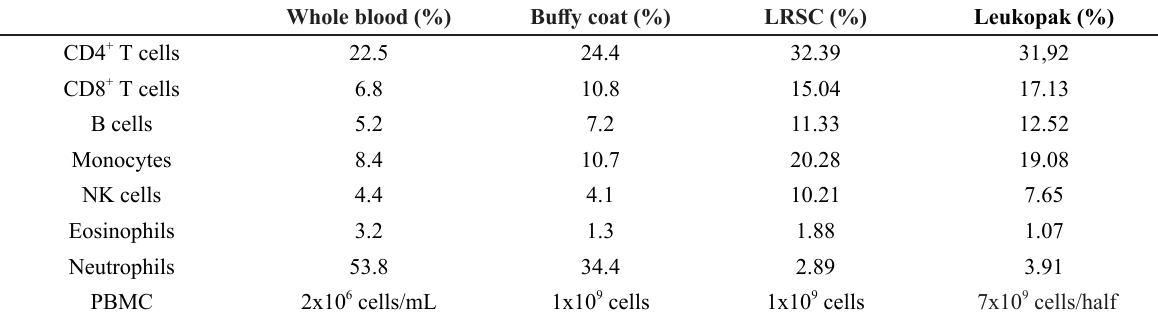
Percentage of cells in whole blood and blood products in health individuals.